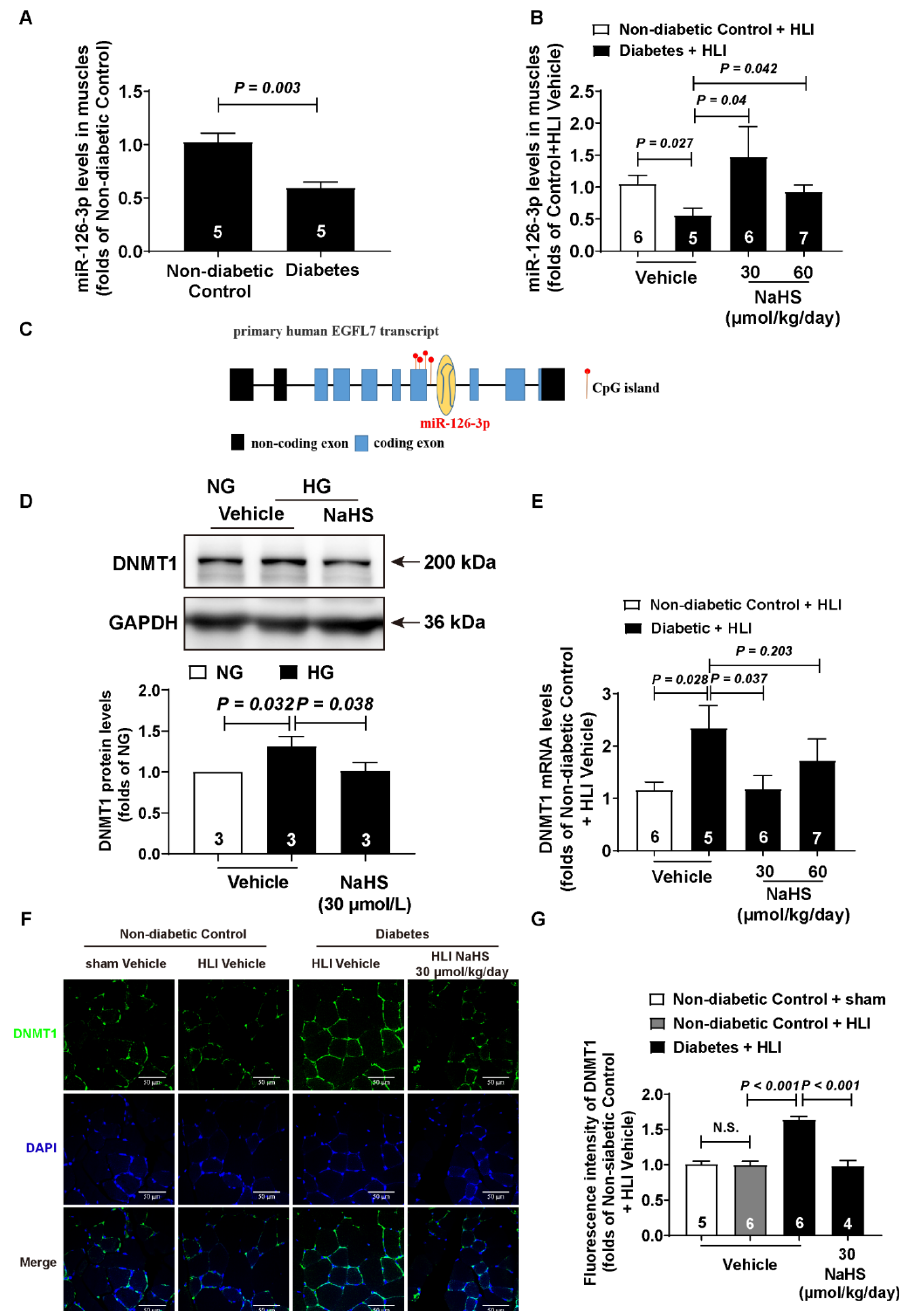
Figure 3. Exogenous H 2 S enhanced the miR-126-3p level and decreased the DNMT1 level in the gastrocnemius muscles of diabetic mice. ( A ) miR-126-3p levels in diabetic muscles compared to the non-diabetic controls; n = 5. ( B ) miR-126-3p levels in the ischemia muscles of diabetic mice with NaHS (30 and 60 µ mol/kg/day) treatment compared to the non-diabetic controls; n = 5~7. ( C ) Schematic illustration of CpG islands before the gene of miR-126-3p. ( D ) DNMT1 protein level of HUVECs with NaHS (30 µ mol/L) treatment under high-glucose conditions; n = 3. ( E ) DNMT1 mRNA level in the ischemia muscles of diabetic mice with NaHS (30 and 60 µ mol/kg/day) treatment compared to the non-diabetic controls; n = 5~7. ( F , G ) Representative micrographs showing DNMT1 with rabbit antibodies against DNMT1 and statistical analysis of the DNMT1 protein expression in the gastrocnemius muscles of diabetic hindlimb ischemia mice compared to non-diabetic mice with or without NaHS (30 µ mol/kg/day) treatment; bar = 50 µ m, n =